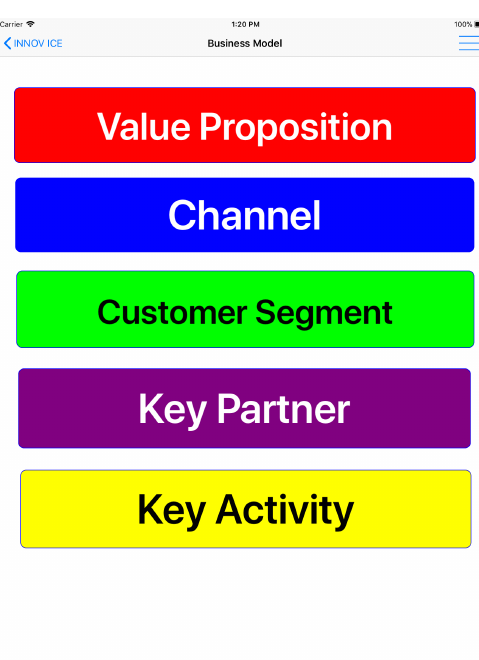
Figure 7. Screenshots of ICE4B. The left part of the figure shows the simplified structure of the business model presented in this paper, whereas the right part shows an example of an actual business